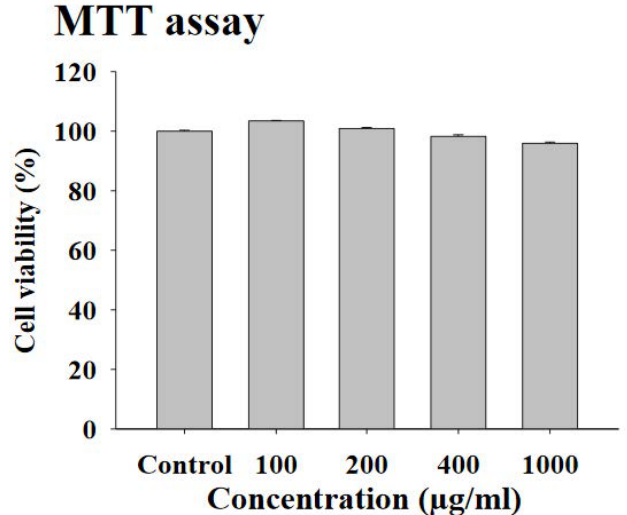
Figure 1. Effects of fermented white sword bean extract (FWSBE) on cell viability of 3T3-L1 preadipocytes. The 3T3-L1 cells (5 × 10 4 cells/mL) were treated with FWSBE at various concentrations (100, 200, 400, and 1000 μg/mL) for 24 h. Cell viability was measured by 3-(4,5-Dimethylthiazol-2-yl)-2,5-diphenyltetrazolium bromide (MTT) assay. Values are presented as mean ± standard deviation.